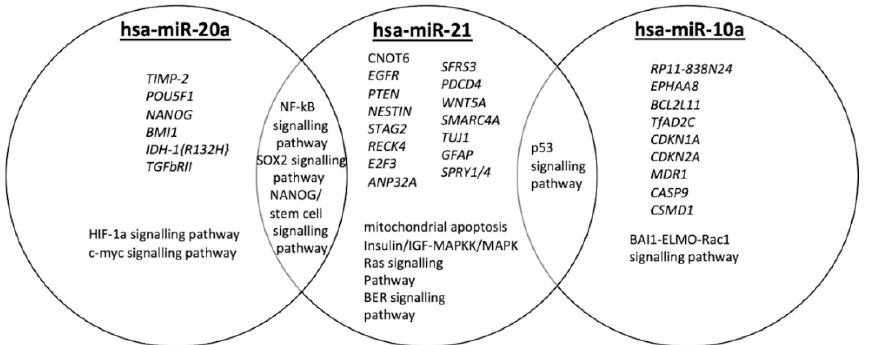
Figure 1. Qualitative Venn diagram of data and text mining findings. Venn diagram representing genes and GBM-related pathways targeted by hsa-miR-20a, hsa-miR-21 and hsa-miR10a.